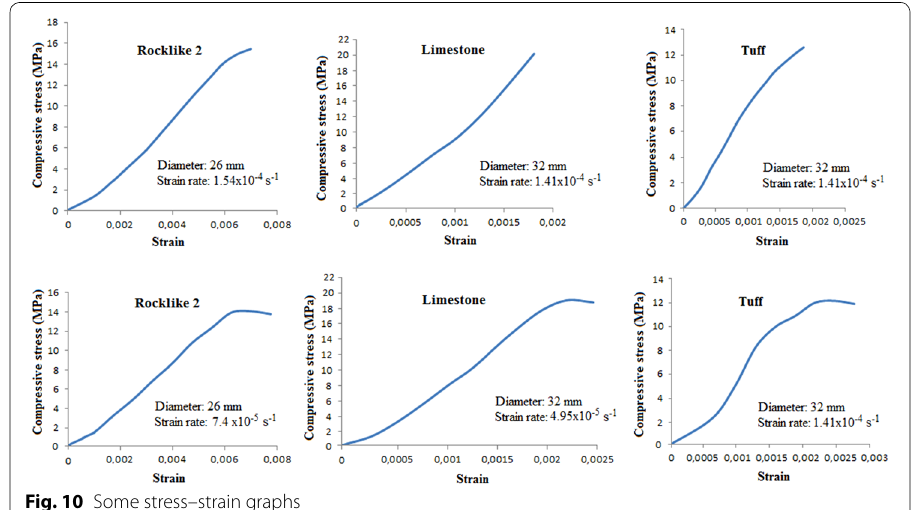
Fig. 10 Some stress–strain graphs